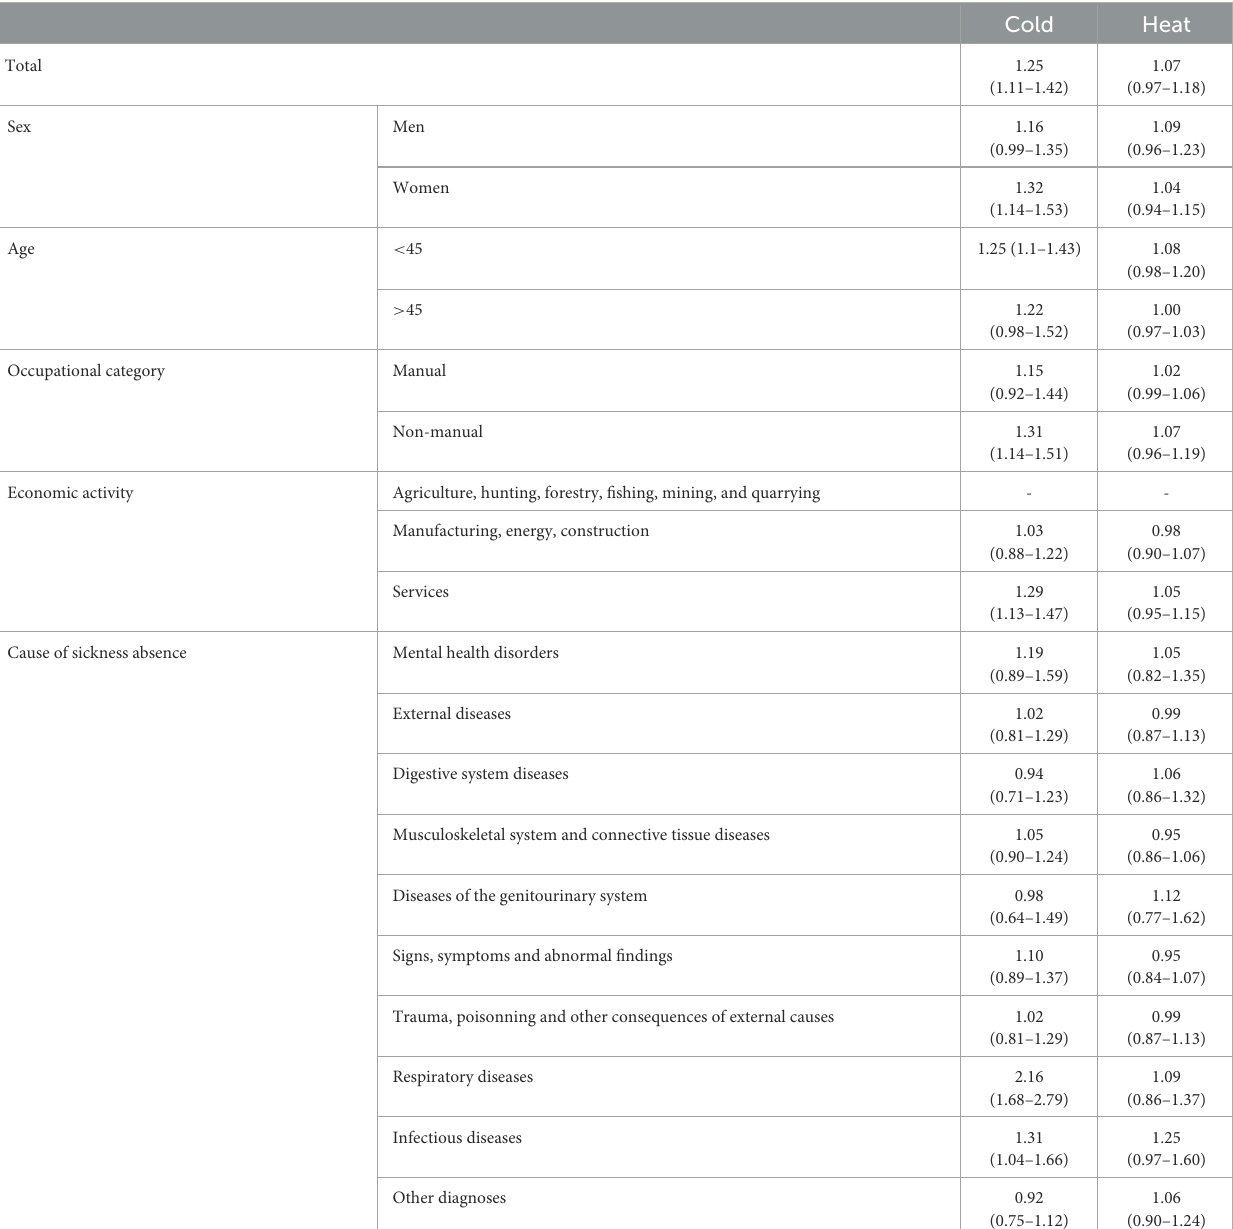
TABLE 2 Relative Risk (95% confidence intervals) for the association between cold and heat and sickness absence in Barcelona by sex, age, occupational category, economic activity and cause of sickness absence for the period